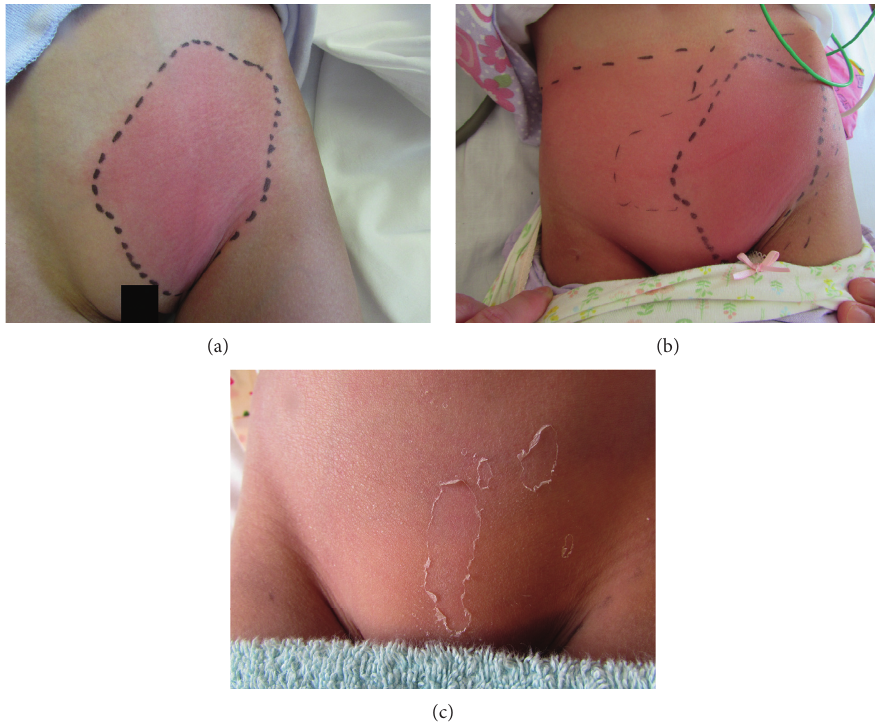
Figure 1: Inguinal lymphadenitis with cellulitis. (a) At admission., skin erythema was observed in the left inguinal area. (b) Before intravenous immunoglobulin treatment, inguinal cellulitis expanded to the entire lower abdomen. (c) After treatment, lamellar des- quamation of the left inguinal region was